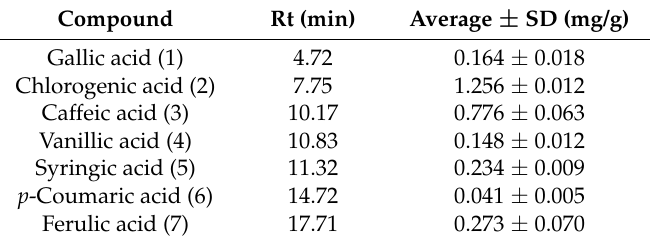
Table 1. HPLC quantitative analysis of the ethanolic extract from dandelion root. The values are expressed as mean ± standard deviation (SD) of milligram (mg) of compound per gram (g) of extract ( n = 3).